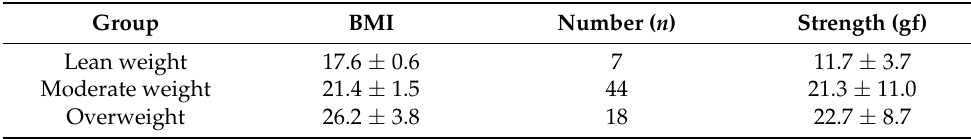
Figure 8. BMI–pulse strength statistics. Table 5. BMI–pulse strength parameter statistical